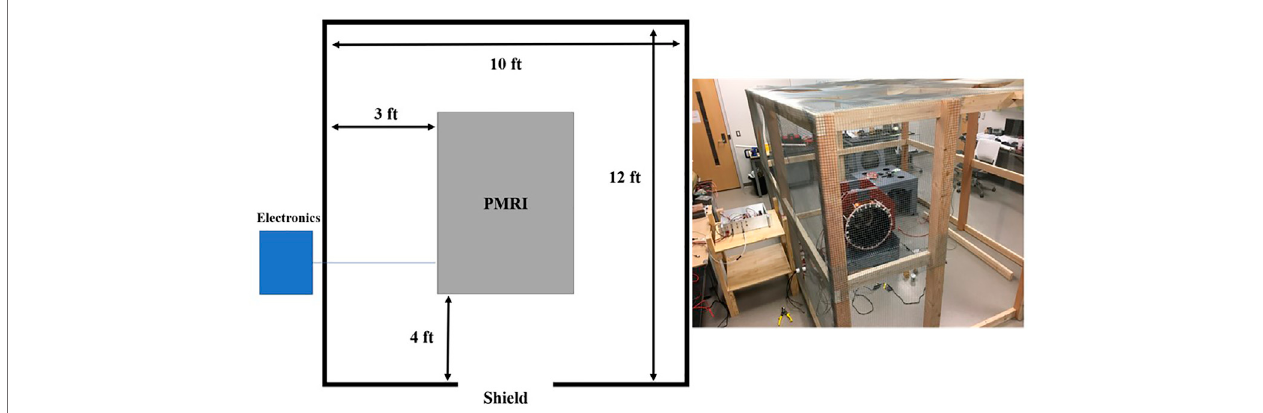
FIGURE 6 | Footprint of the shield enclosure (left) with image of constructed shield (right). The shield was constructed using 2 × 4 s and chicken wire.